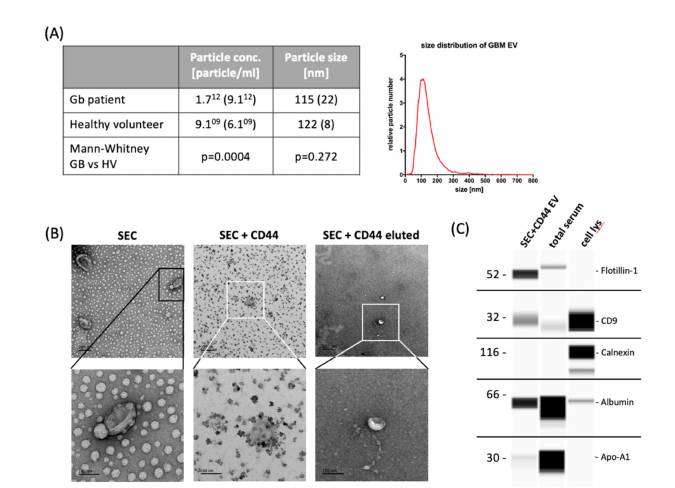
Figure 1. Yield and characteristics of serum-derived extracellular vesicles. ( A ) NTA of extracellular vesicles (EVs) isolated from 500 µ L serum by size-exclusion chromatography (SEC) to determine the yield and particle size. The table states the mean particle concentration and mean modal size of 55 glioblastoma patients and 5 healthy volunteers (HV). Standard deviation is given in parentheses; histograms: exemplary size distribution of glioblastoma-EVs measured by NTA. ( B ) Transmission electron microscopy images showing the typical EV morphology. Scale bar represents, in all images, 200 nm in the upper row (30k × magnification) and 100 nm in the lower row (110k × magnification). Images in the left lane show EVs after SEC, middle lane images show CD44-captured SEC-EVs, and right lane images represent EVs that were diluted from CD44-beads. ( C ) Wes ProteinSimple immunodetection confirming the presence of the EV-markers flotillin-1 and CD9 and the absence of non-EV protein calnexin in SEC + CD44 EV preparations. Cell and total serum lysates were used as positive controls for the non-EV marker calnexin, apolipoprotein A1, and serum albumin, respectively. NTA = nanoparticle tracking analysis; cell lys = cell lysate of PBMCs (1:10) or glioblastoma cell line Gli36 (1:100); Apo-A1 = apolipoprotein A1.